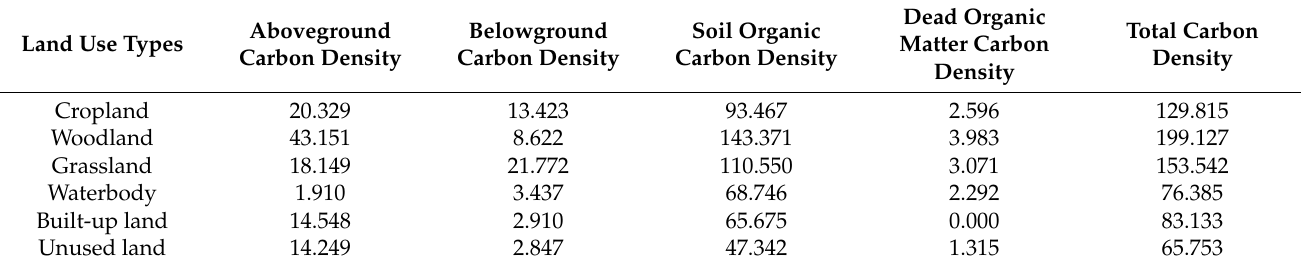
Table 4. Carbon intensity of each land use type in the YRD (t/hm 2 ).